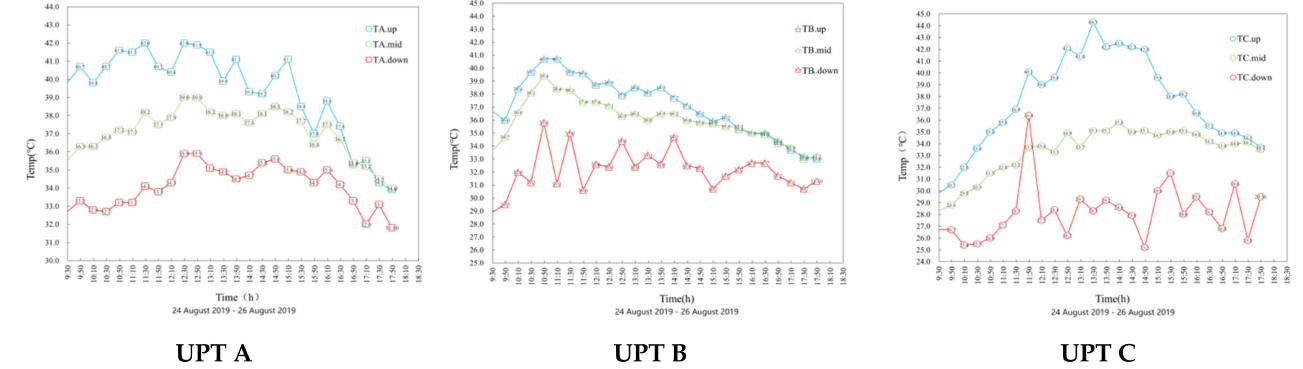
Figure 3. Indoor air temperature vertical stratification of tested UPTs.